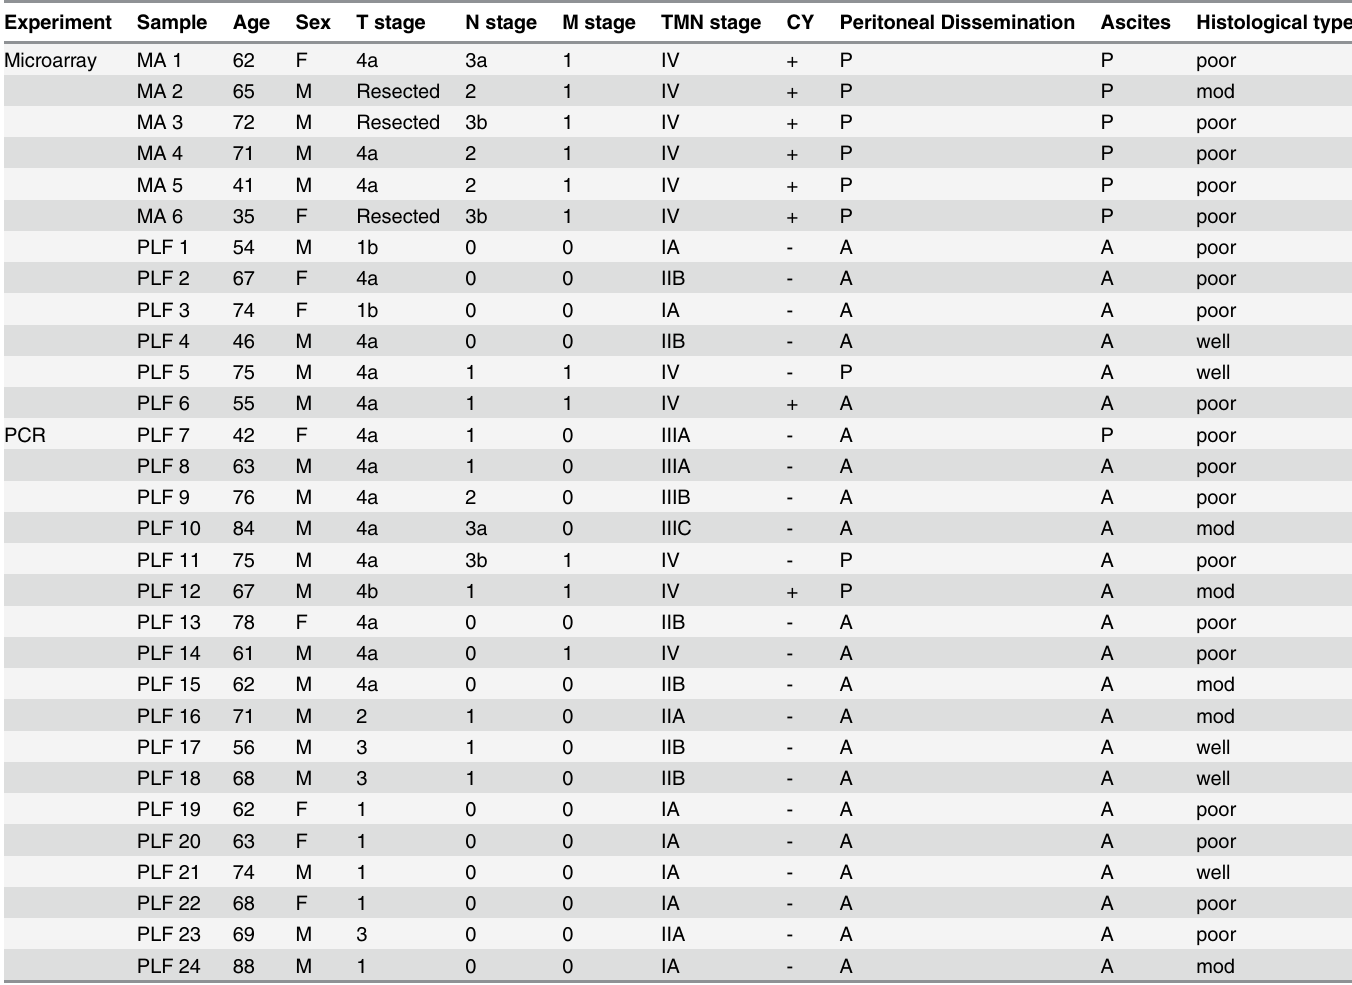
Table 1. Clinicopathological characteristics of patients with gastric cancer. Well-differentiated adenocarcinoma (well); moderately differentiated ade- nocarcinoma (mod); poorly differentiated adenocarcinoma (poor). Malignant ascites (MA); Peritoneal lavage fluid (PLF); TMN stage (UICC 7th edition); Pres- ent (P) Absent (A); Peritoneal lavage cytology